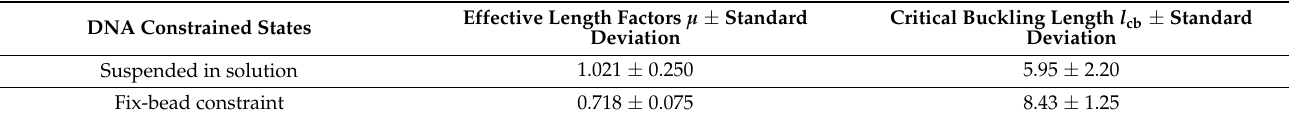
Table 2. Effective length factors and critical buckling lengths for DNAs suspended in solution or with fix-bead constraint.